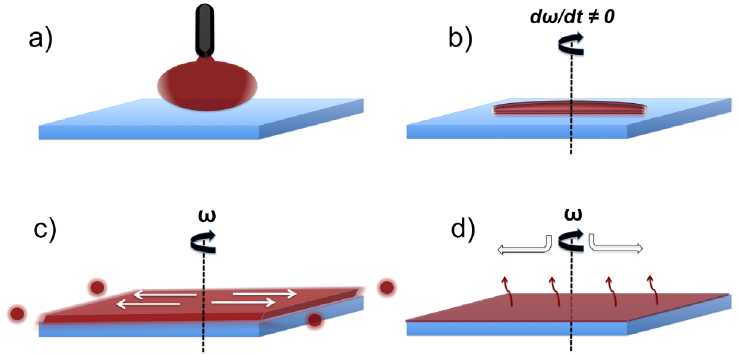
Fig. 15. – Four steps of spin coating as (a) deposition, (b) spin-up, (c) spin-off and (d) evapo-